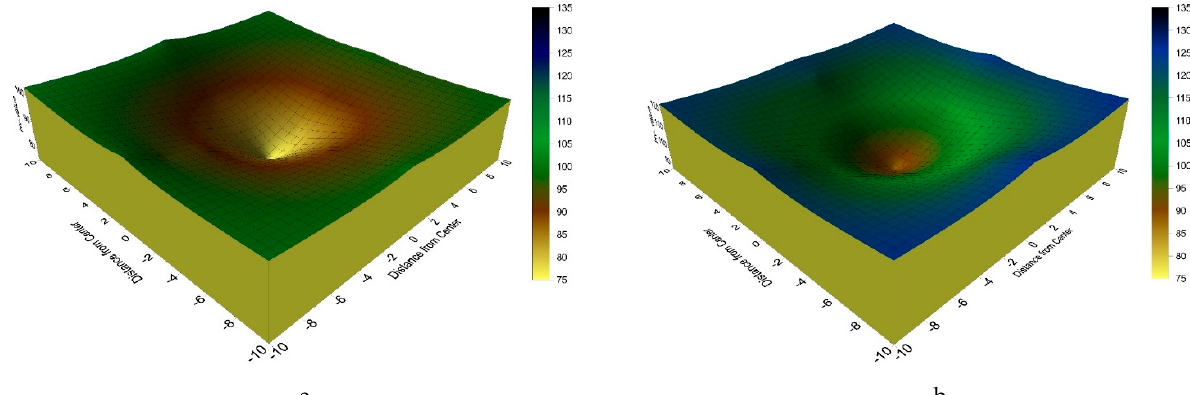
Figure 6 . SEM micrographs of the AZ31 alloy after corrosion test ( a,b ) AA, ( c,d ) 1-P, and ( e,f ) 2-Bc at ( a,c,e ) high magnification and ( b,d,f ) low magnification coupled with the EDS spec- trum .